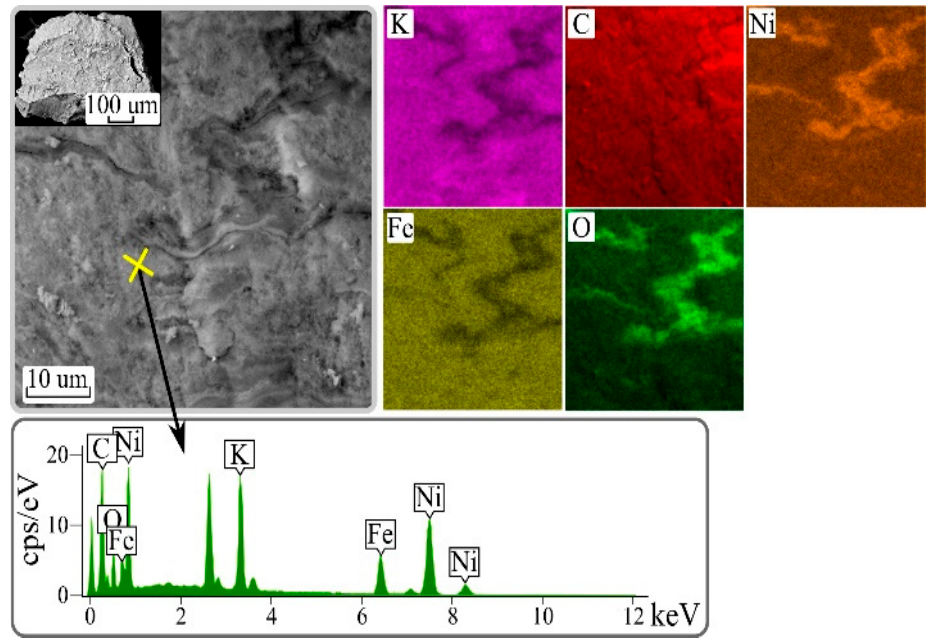
Figure 3. SEM-EDX analysis of the composite CS/FOC K-Ni; X-ray spectrum and distribution of elements K, C, Fe, O, and Ni.